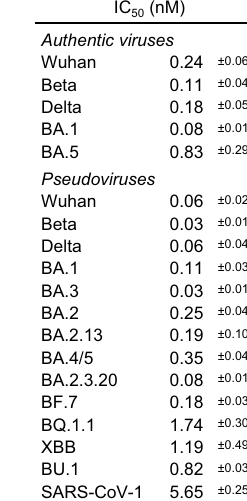
standard deviations of representative assays performed in duplicates is shown. Neutralization of authentic viruses were repeated with similar results three times for Wuhan, twice for Delta, BA.1, and BA.5 and once for Beta in experiments per- formed in quintuplicate and involved counting of approximately 25,000 cells per conditionafterimmunostainingillustratedinthe fi gureinsert.Theoriginaldataare provided as a Source Data fi le. An alignment of RBD sequences of spike variants used in this study is shown in Fig.